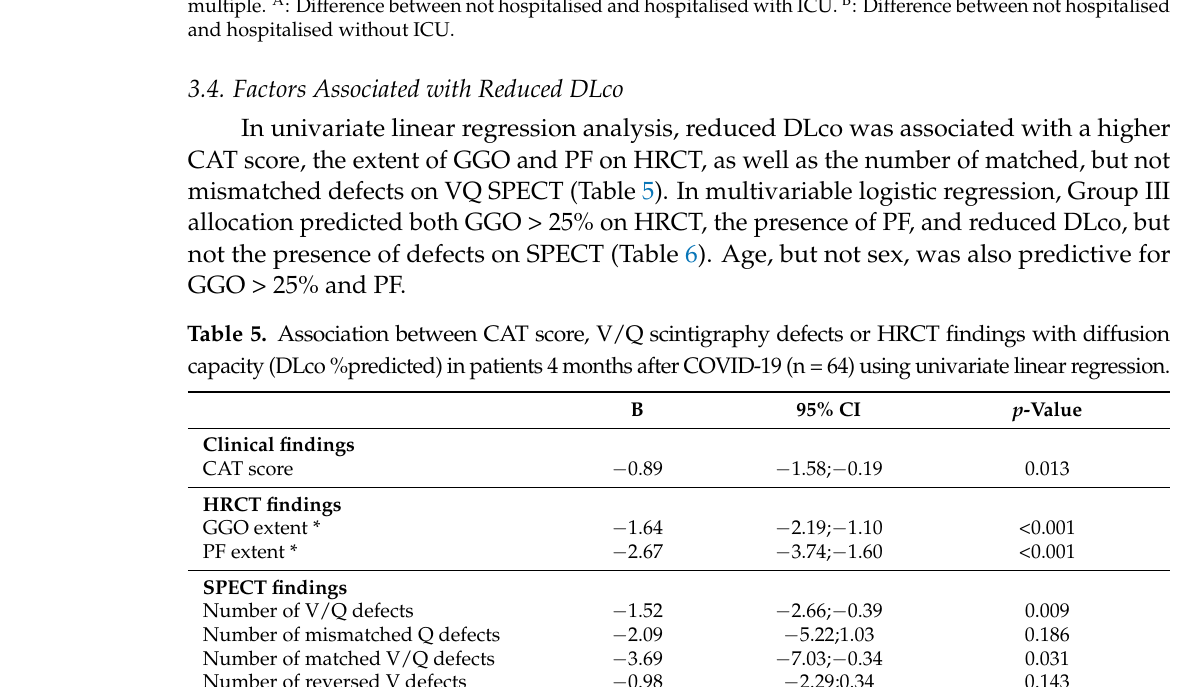
V = ventilation; Q = perfusion. Mismatched Q defects = perfusion defects, but normal ventilation in the area. Reverse mismatched V defects = ventilation defects, but normal perfusion in the area. Data are expressed as n (%), total sum of defects or ratio between number of subsegmental defects and number patient with subsegmental defects. # Fisher’s exact test and if significant followed by bivariate comparison with Bonferroni correction for multiple. A : Difference between not hospitalised and hospitalised with ICU. B : Difference between not hospitalised and hospitalised without ICU.